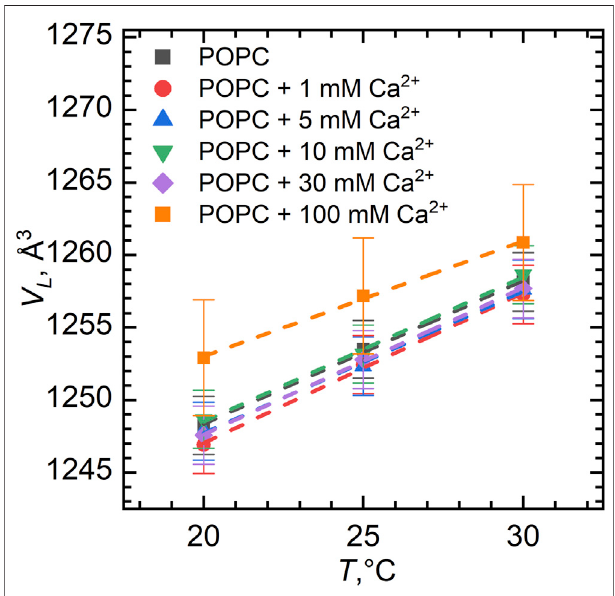
FIGURE 1 | Volume per lipid V 2+ L in POPC vesicles for different Ca concentrations as a function of temperature. The error bars show systematic errors calculated based on sample preparation protocol (uncertainties in lipid weighing, and buffer volume added to the lipid powder,